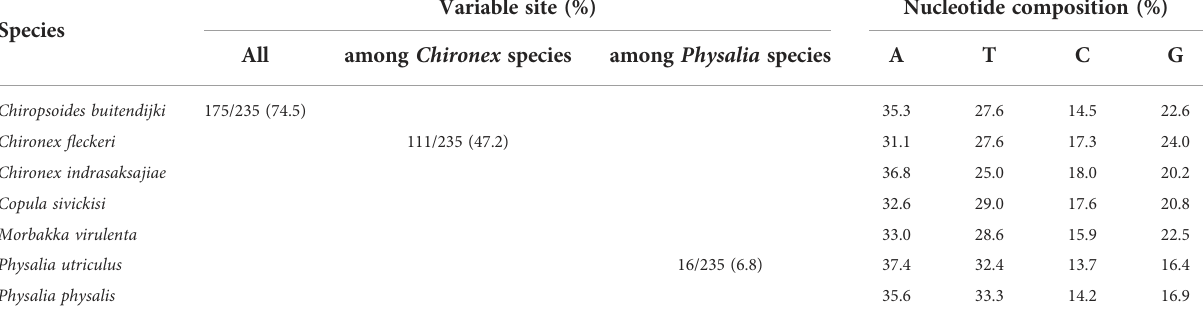
TABLE 4 showing nucleotide variations and content of seven venomous jelly fi sh species.